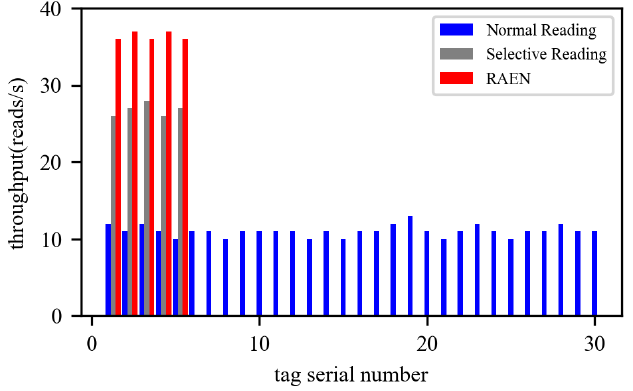
Figure 12. The improvement effect on effective node throughput.